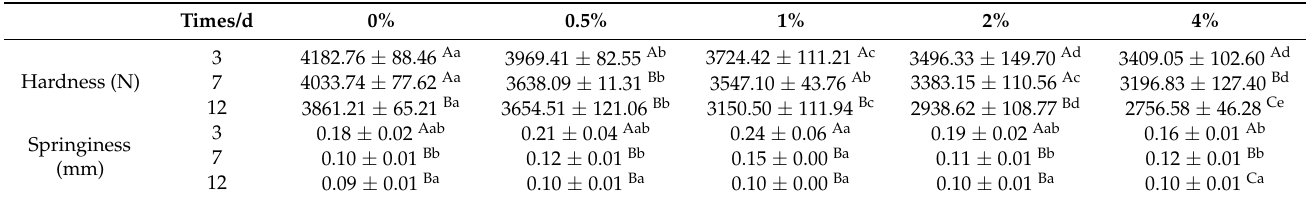
Table 2. Effects of LNT content and storage time on texture of goose meatballs during cold storage (4 ◦ C).